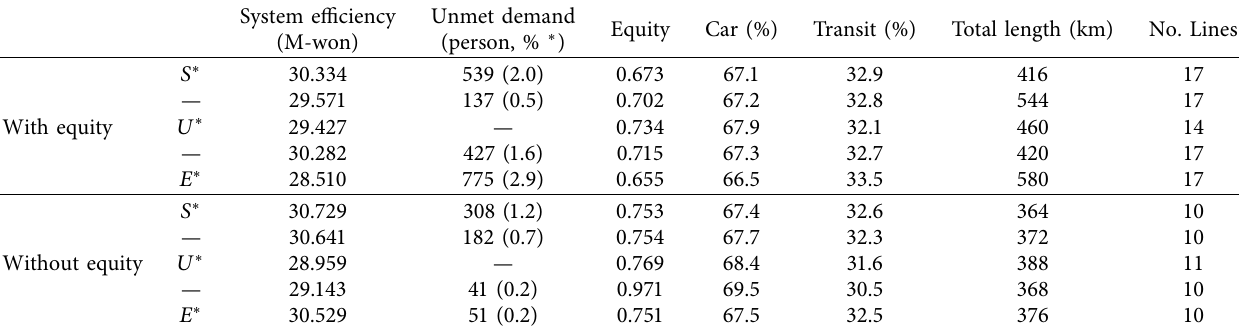
Table 5: Pareto optimal solutions with and without equity.